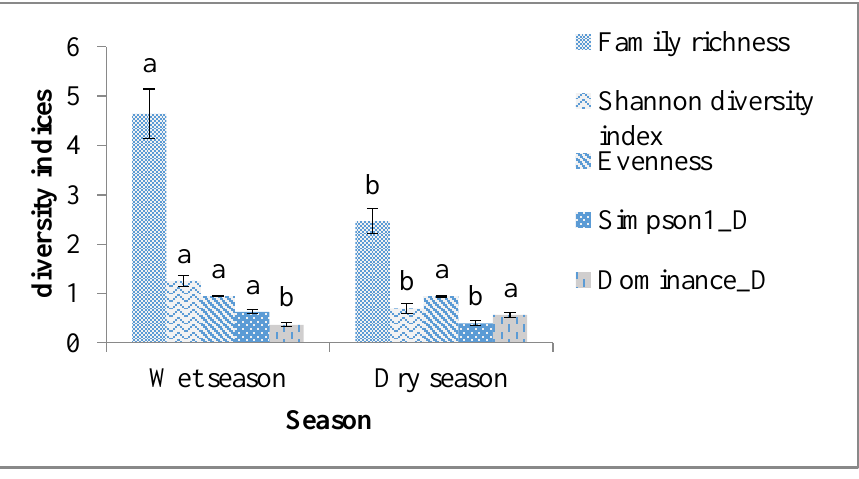
Figure 5. Effect of season on SMI diversity. Different letters above the bars indicate significant differences between seasons. Bars indicate mean ± SEM.